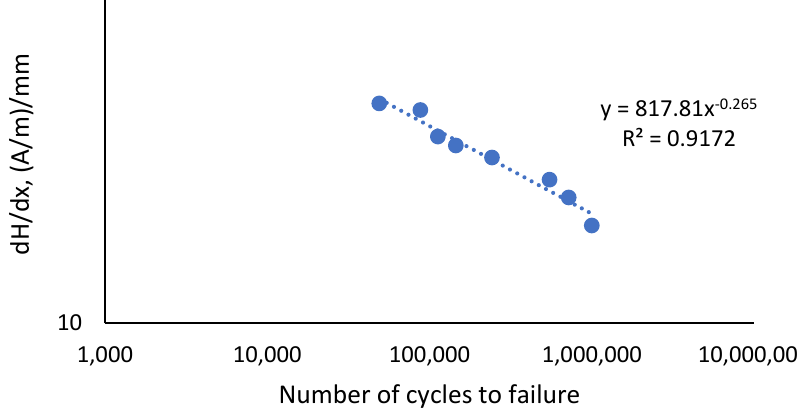
Figure 12. Correlation of dH(y)/dx value with all experimental fatigue life.